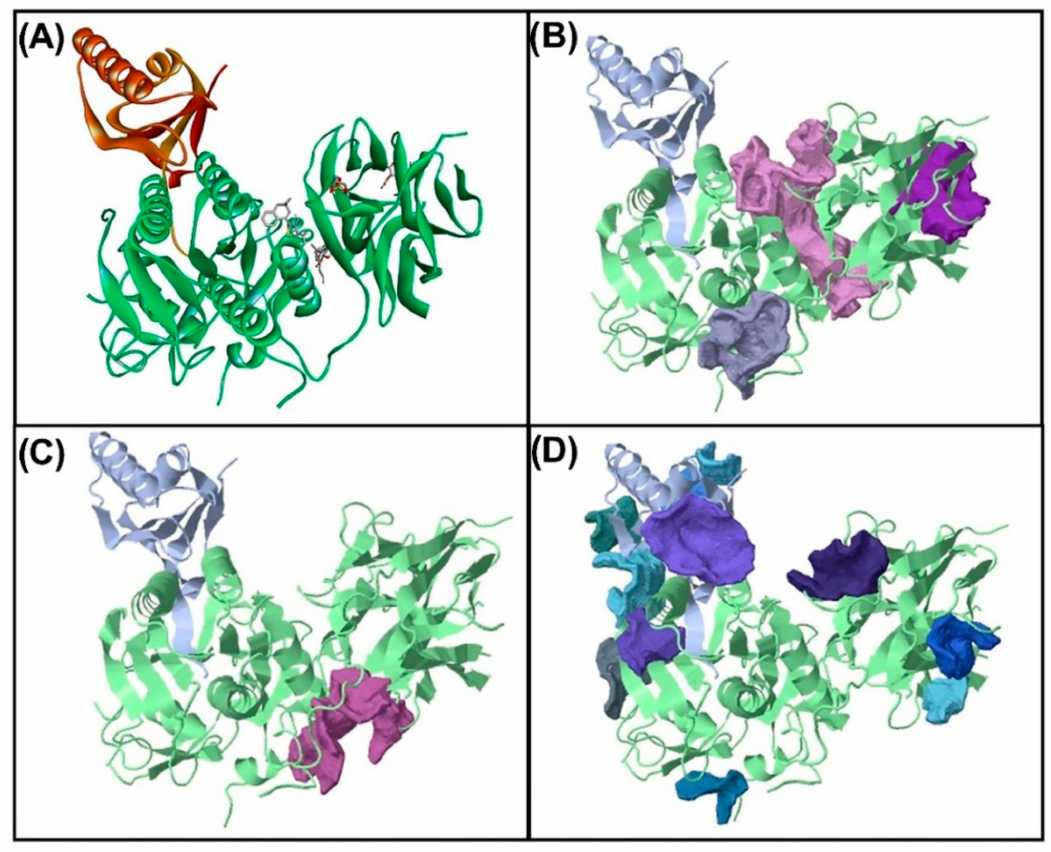
Figure 4. The pocket binding sites of the ( A ) PCSK9 protein at ( B ) high, ( C ) medium, and ( D ) low binding affinity was analyzed with CavityPlus (http://www.pkumdl.cn/cavityplus, accessed on 2 November